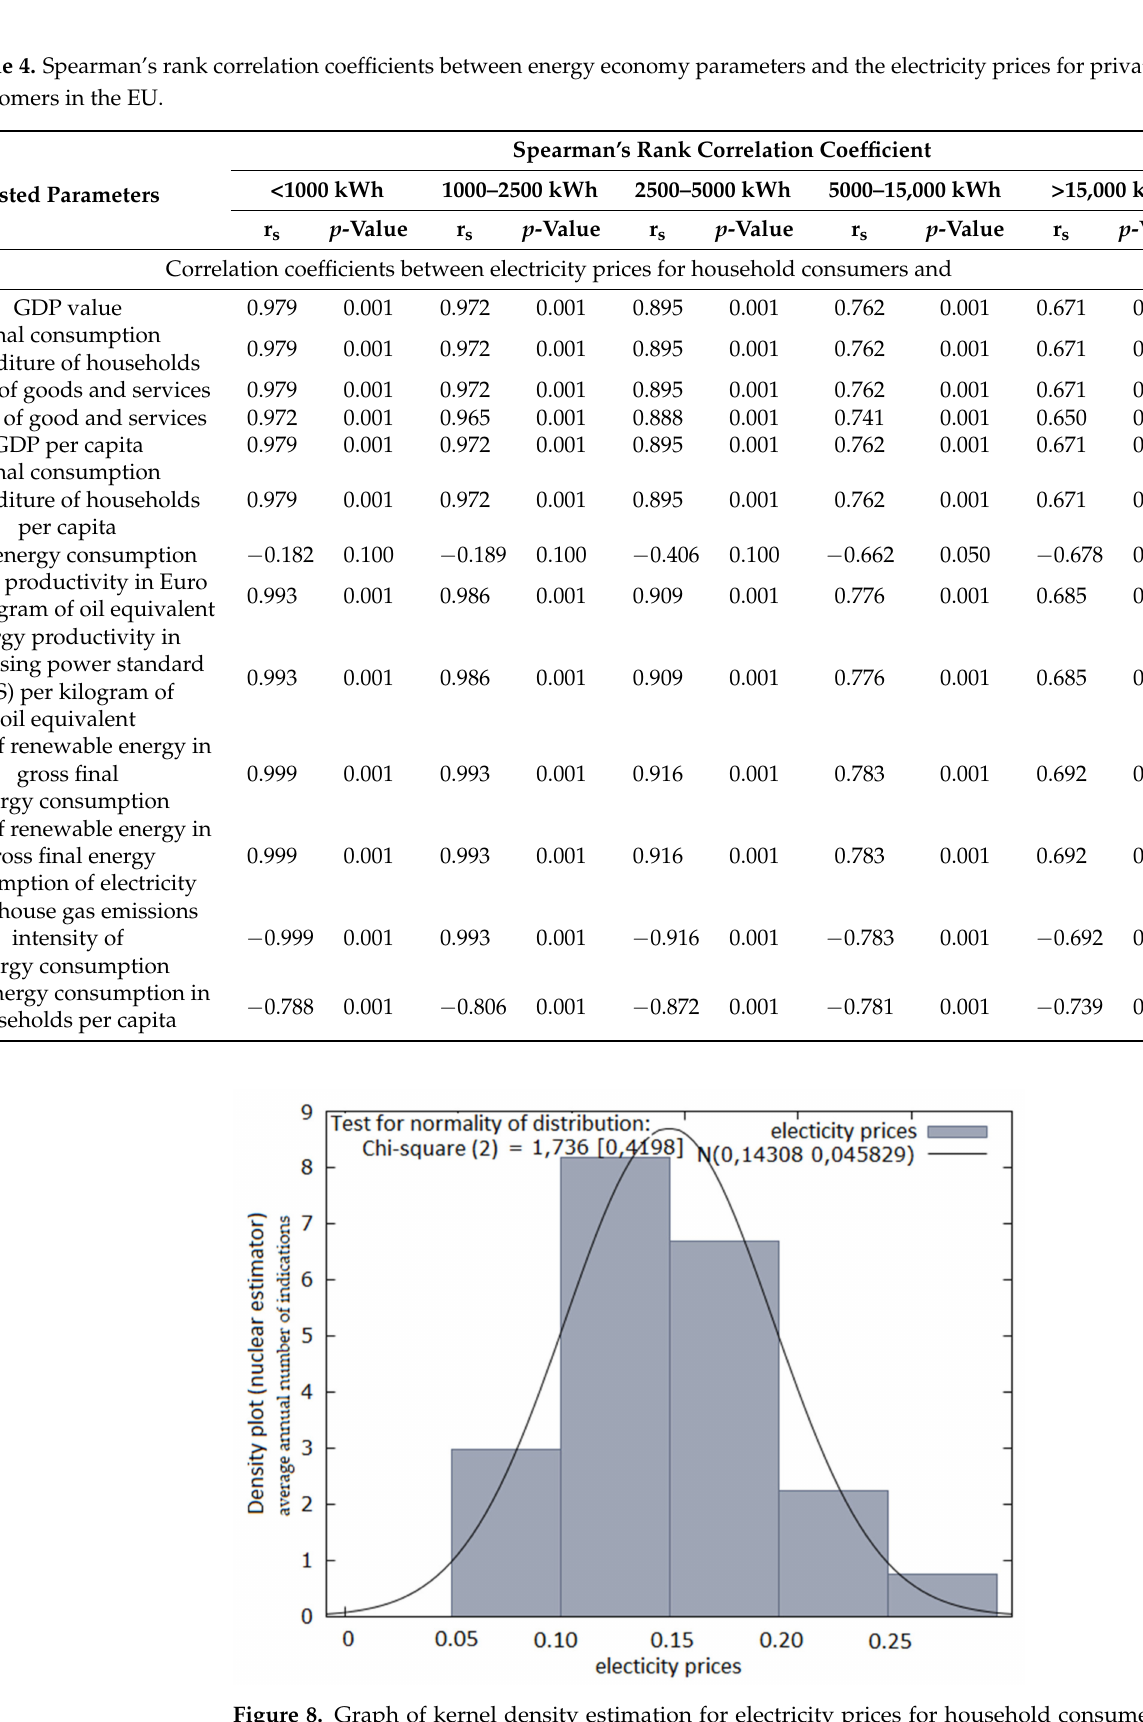
Figure 8. Graph of kernel density estimation for electricity prices for household consumers in a group consuming 2500–5000 kWh in EU in